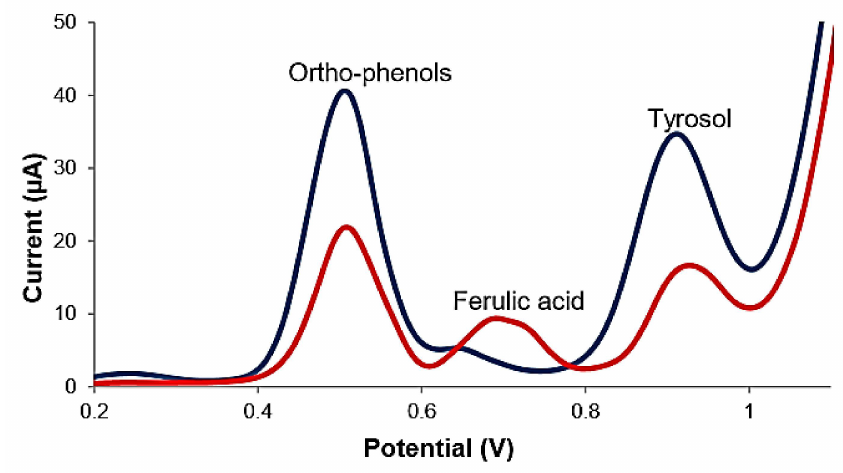
Figure 5. DPV voltammograms of a mixed standard solution formed by hydrophilic phenolic compounds of 10 mg L − 1 concentration in HCl 0.1 M (red) solution and a virgin olive oil sample in HCl 0.1 M solution after the RP DLLME (blue) procedure. Published from [32] with the permission of the